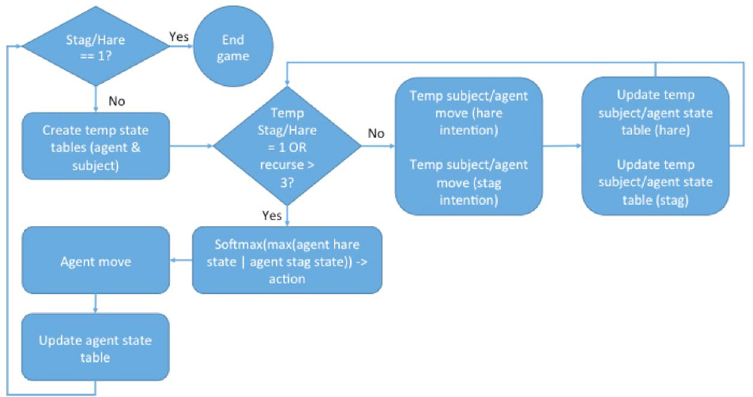
Figure 2. Flow chart of the theory of mind planning (ToMPlan) model. On each turn, if an endgame was not reached through a stag or hare capture, the model would decide upon an action of either moving closer to the hare or the stag using state table information run through a Softmax function. The agent would then move one square on the game board, update the state tables, and iterate again. While an endgame state was not reached, a temporary copy of the state tables was made and a sample game for both hare and stag outcome was simulated until either endgame state was reached or three levels of recursion were completed. The prey with the simulated game containing the highest valued end state was selected, and this state was run through the Softmax function to return a prey to act upon. This model held state tables for both the agent and the